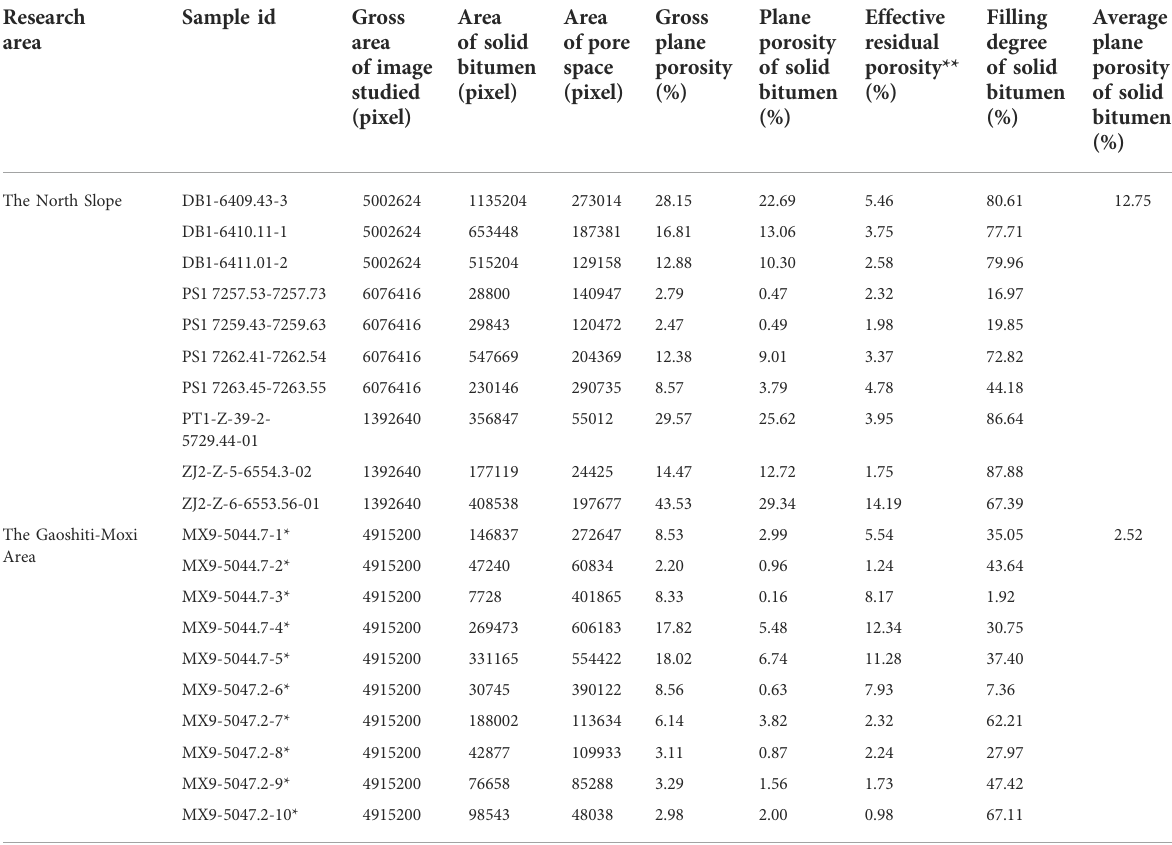
TABLE2Thecontentofthesolidbitumen intheporespacewasobtainedfromcastingthinsectionmicrographsusingtheimageprocessingmethod.